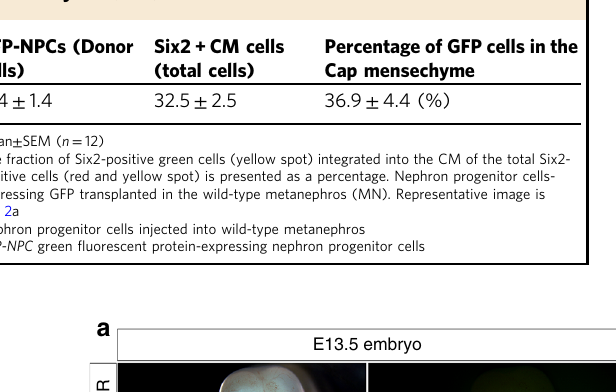
Table 1 Measurement of the replacement rate in the cap mesenchyme (CM)